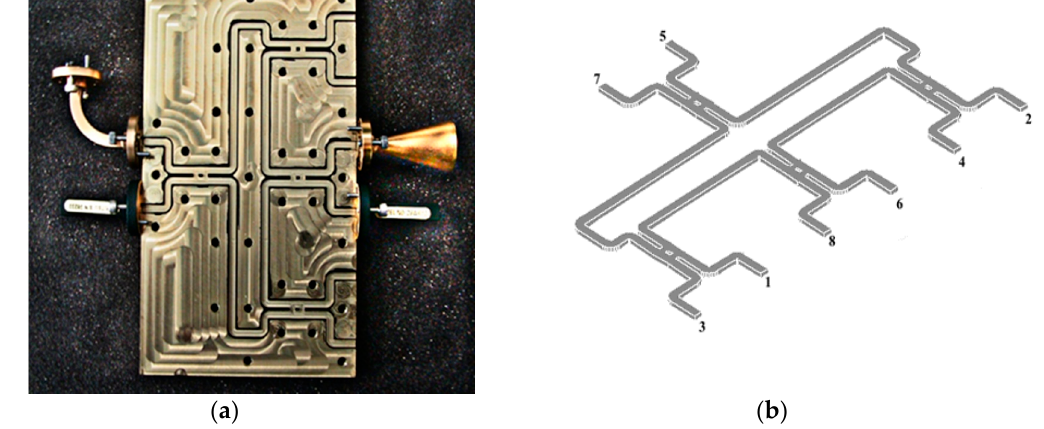
Figure 3. Layout of rectangular wave-guide (RWG) brass multi-port: ( a ) photo of a section; ( b ) lay-out.